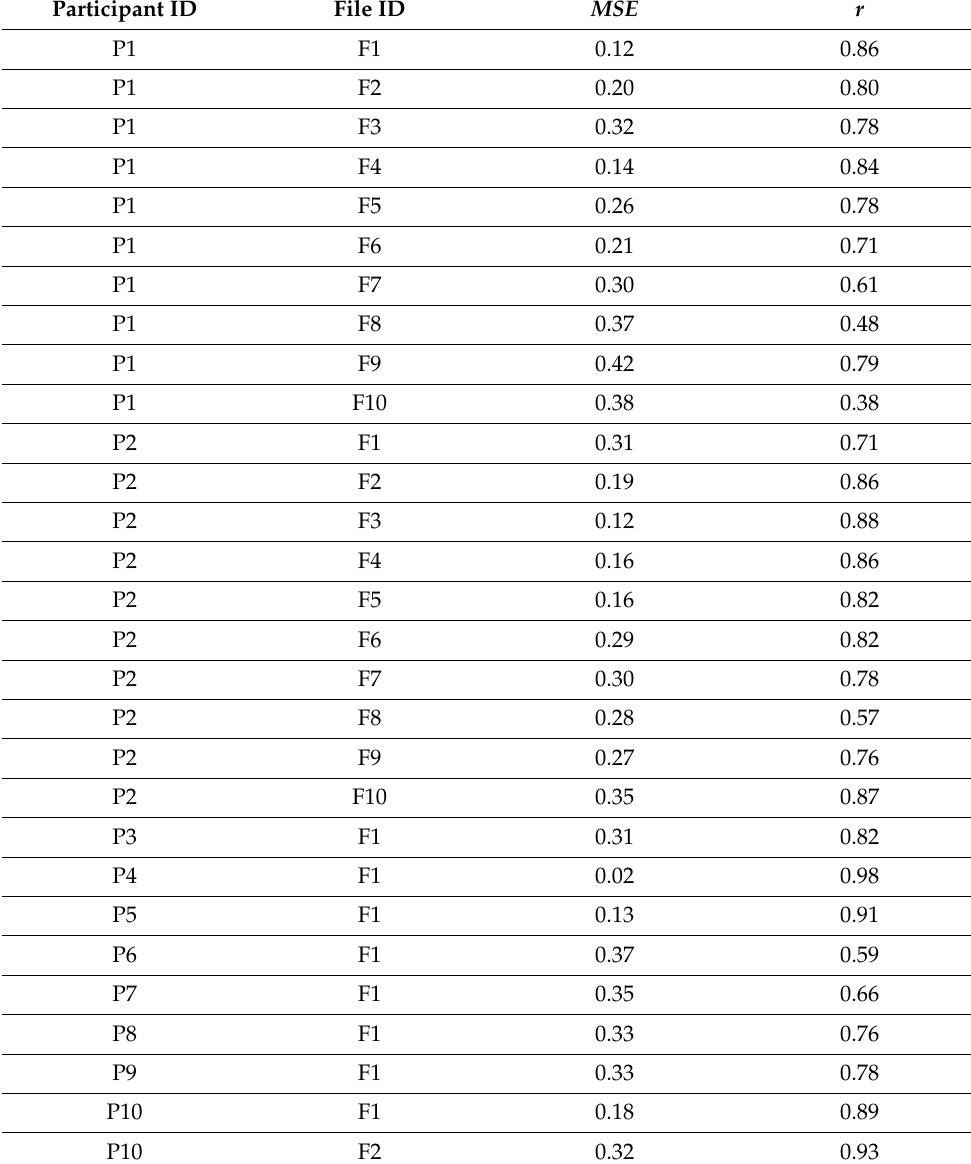
Table 3. Prediction performances by the first